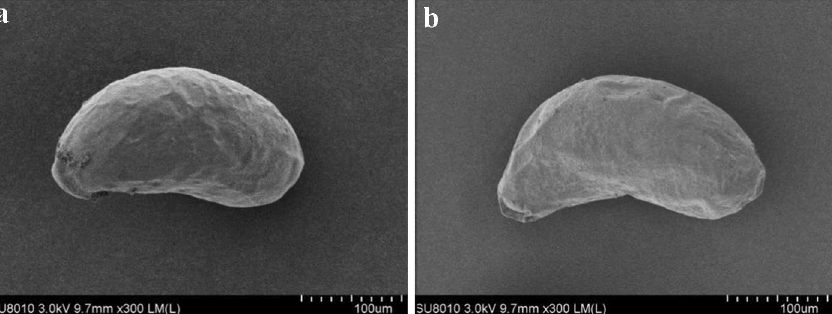
Figure 8. The effect of spirotetramat on the egg shell surface of F. occidentalis 24-h-old eggs. ( a ) 24-h-old eggs in the control treatment; ( b ) 24-h-old eggs in the spirotetramat